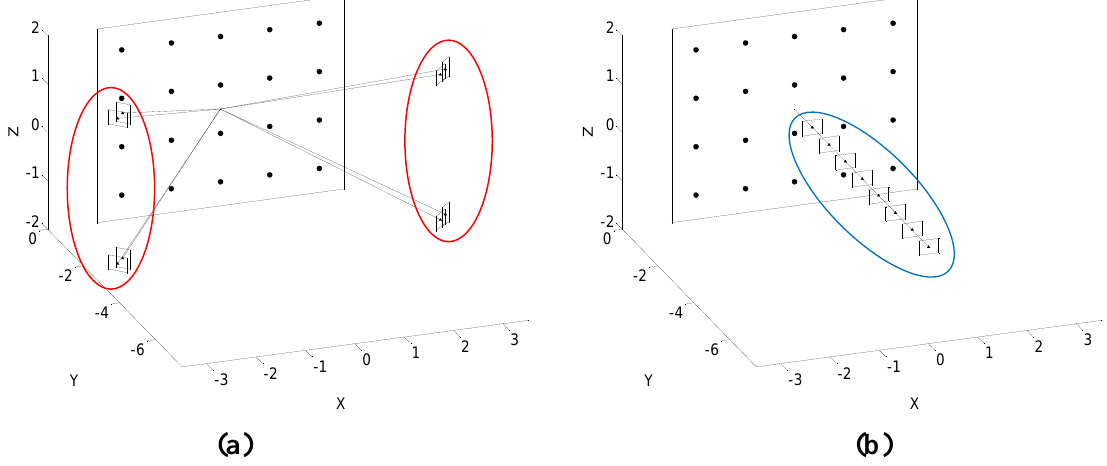
Figure 1. Two-step independent range camera calibration. (a) Camera-lens parameter calibration from x and y observations in the convergent images (red). (b) Range-error calibration from range  observations in the normal images (blue).